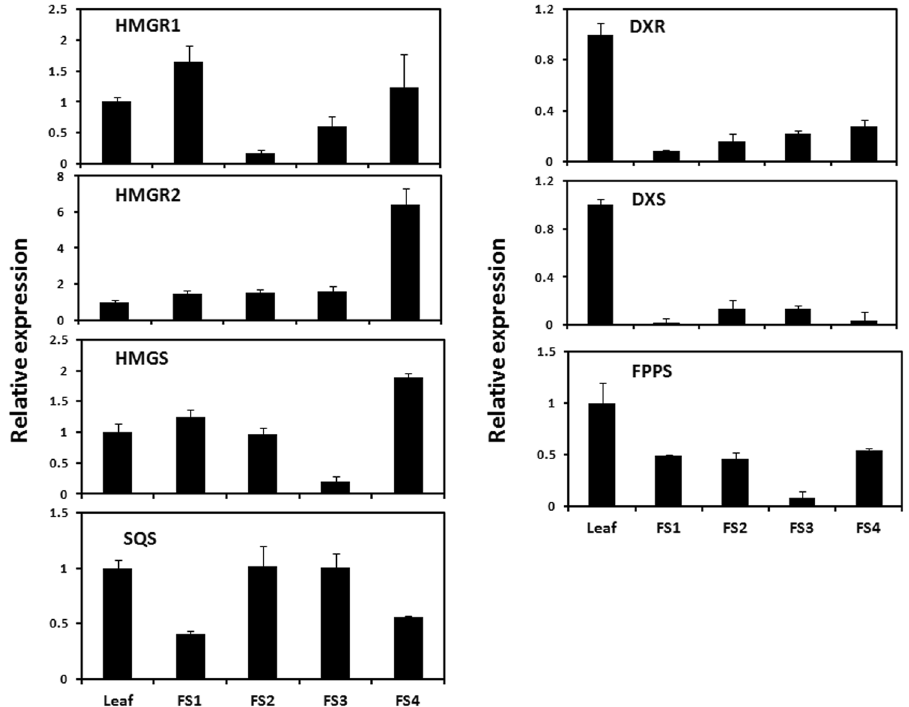
Figure 4. Expression analysis of genes involved in MVA and MEP pathways. Expression was analyzed through qRT-PCR in different plant parts. Leaf, Mature leaf; FS1, Fruit stage 1; FS2, Fruit stage-2; FS3, Fruit stage-3 and FS4, Fruit stage-4. HMGR1 and HMGR2 , 3-Hydroxy-3-methylglutaryl-coenzymeA reductase ; HMGS , 3-Hydroxy- 3-methylglutaryl-coenzymeA synthase ; DXR , 1-Deoxy-D-xylulose-5-phosphate reductoisomerase ; DXS , 1-Deoxy- D-xylulose-5-phosphate synthase ; FPPS , Farnesyl diphosphate synthase ; SQS , Squalene synthase